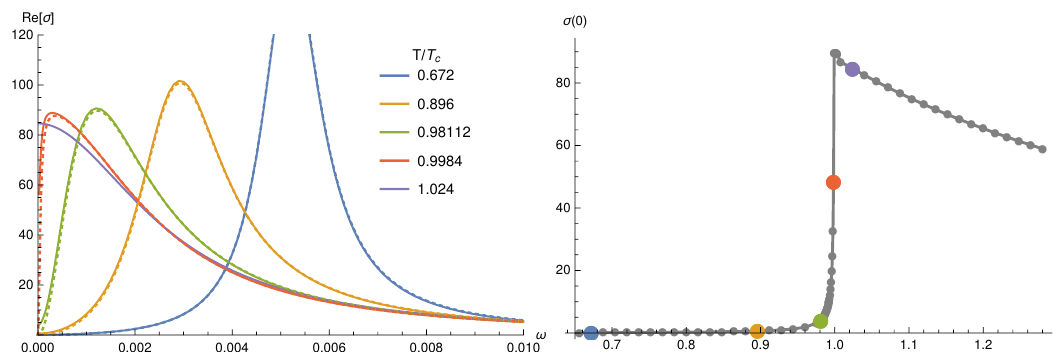
Figure 8 . AC conductivity (Left panel) and its limit at zero frequency (Right panel) in the states with (cid:12)xed explicit symmetry breaking ( (cid:21) = 0 : 5) and changing temperature. The dashed lines show the prediction of (1.2) with parameters extracted from QNM spectrum. The solid lines are the numerical results. Color dots on the right panel mark the parameters for which the AC curves has been